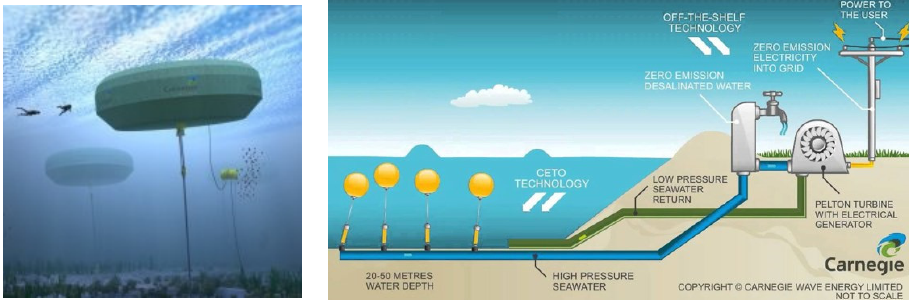
Figure 22. CETO external view [78] and working principle [77].